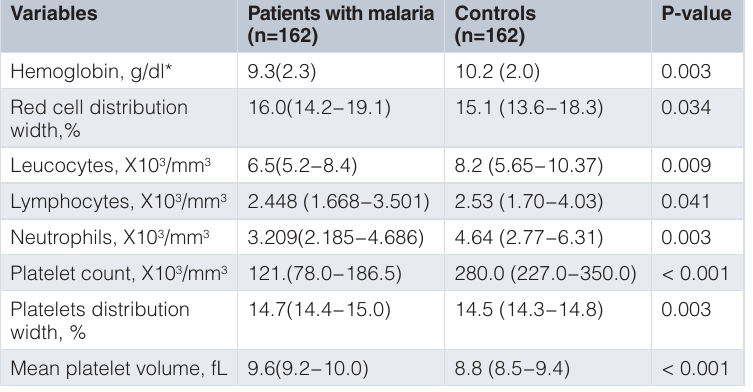
Table 2. Comparing the median (IQR) of the blood parameters measured in patients with and without malaria. Data is displayed as mean (±SD), and the t-test was used because the data was normally distributed.